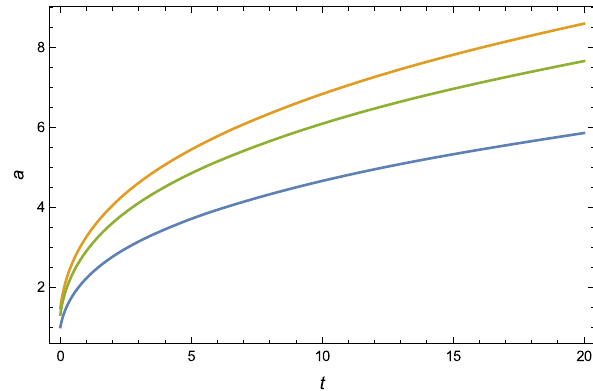
Fig. 15 Evolution of scalar field with respect to redshift for different values of α . Red: α = 3, green: α = 0 . 16, yellow: α = − 0 . 16, blue: α = − 1